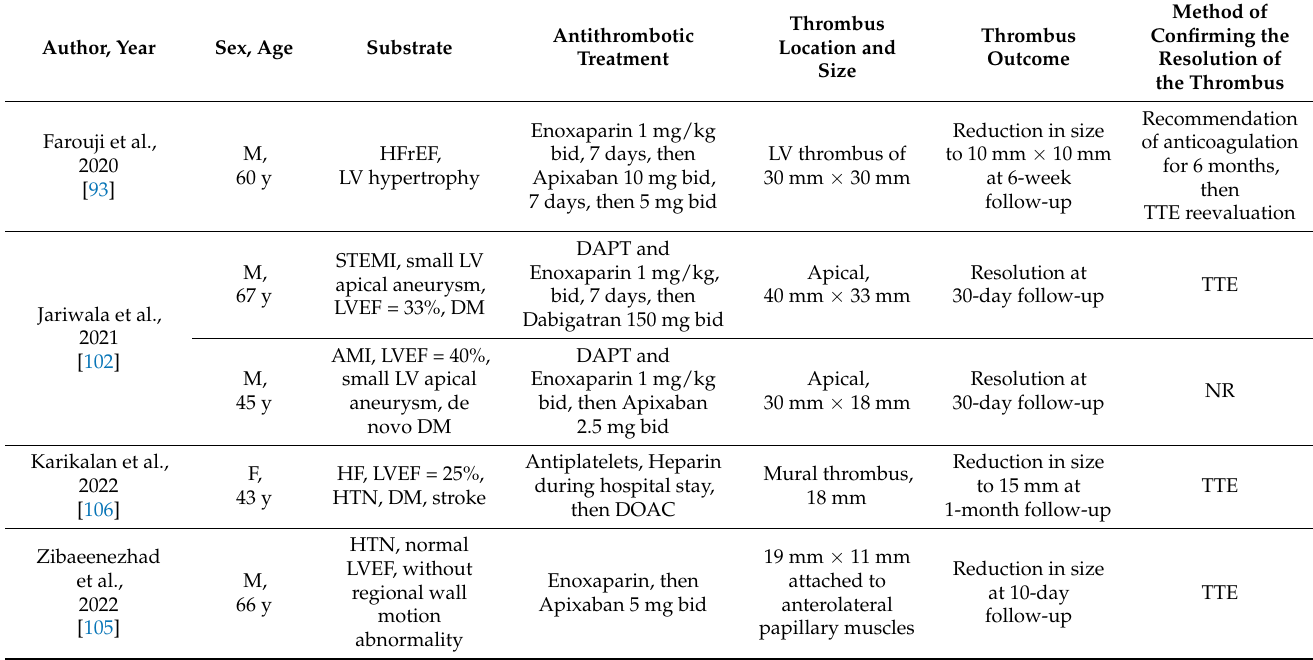
Table 4. Left ventricular thrombus in patients with